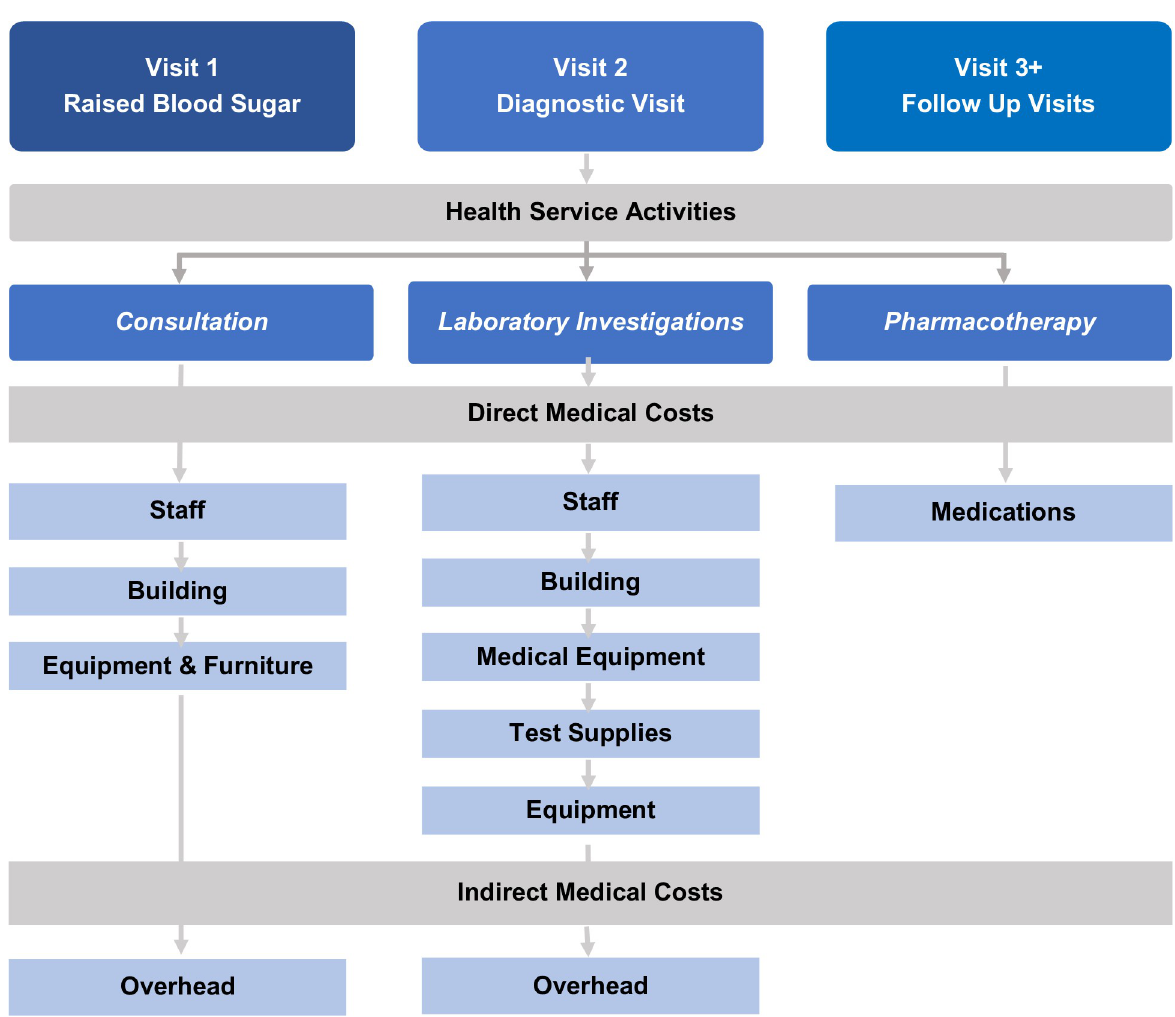
Fig 1. Health service activities and direct/indirect cost items relevant for uncomplicated diabetes in the outpatient department. Costs of follow-ups at the level of health posts or community were not